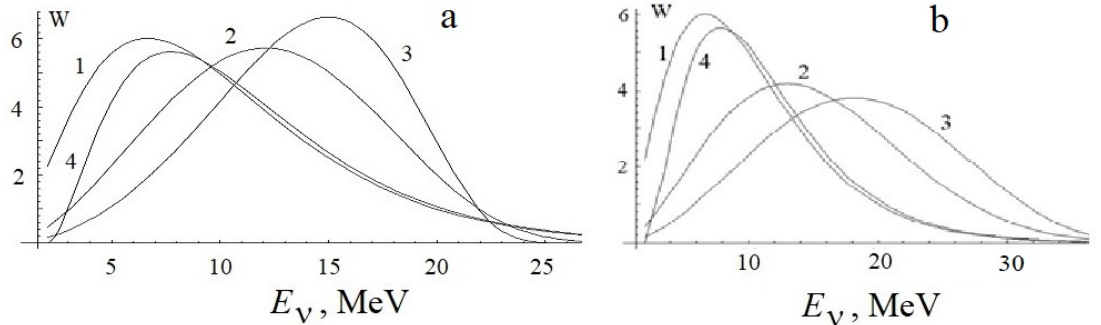
Figure 2. Neutrino energy spectra in arbitrary units for α = 2, E av = 10 MeV, and e l = 1 (i.e., l = 0) — curves 1, 2 — curves 2, and 3 — curves 3 at T = ( a ) 5 MeV ( b ) 10 MeV. The curves 4 correspond to a respective single effective collision event at ∆ = 2 MeV.